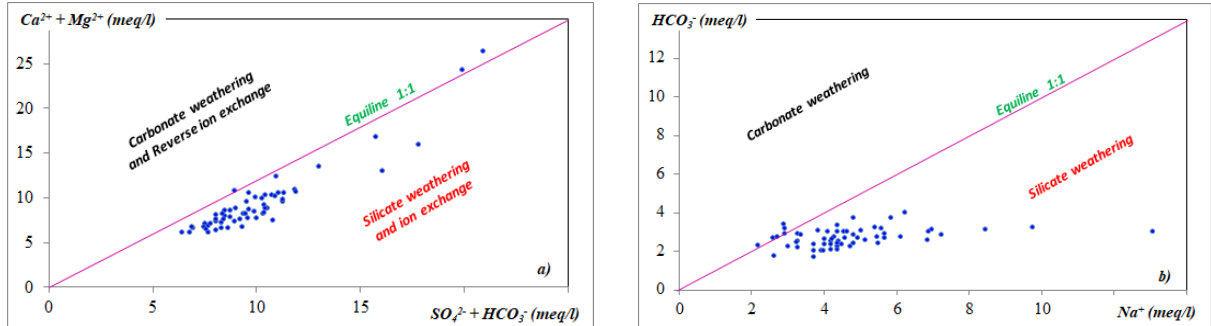
Fig. 7. Scatter diagram of relation parameters of dam water: a – Relation between (Ca 2+ + Mg 2+ ) Vs (SO 4 2- + HCO 3 - ) and b – (HCO 3 - ) Vs (Na + )